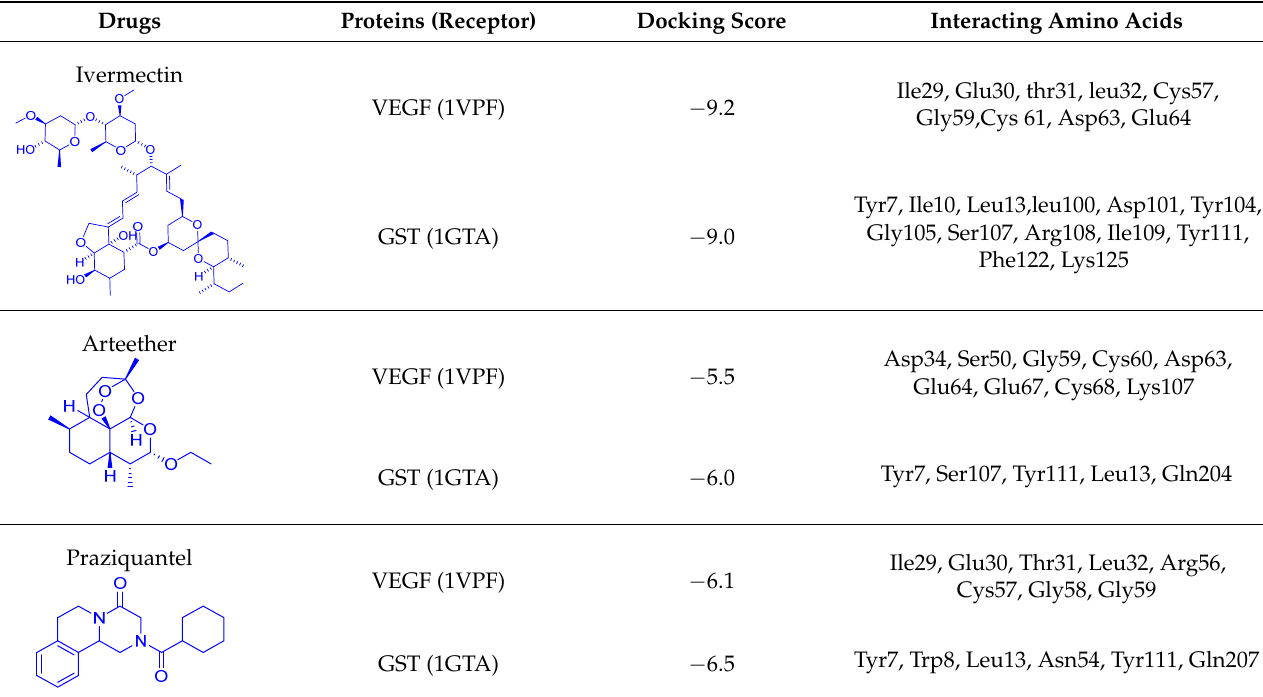
Table 1. Binding energies of selected drugs with targeted receptors.